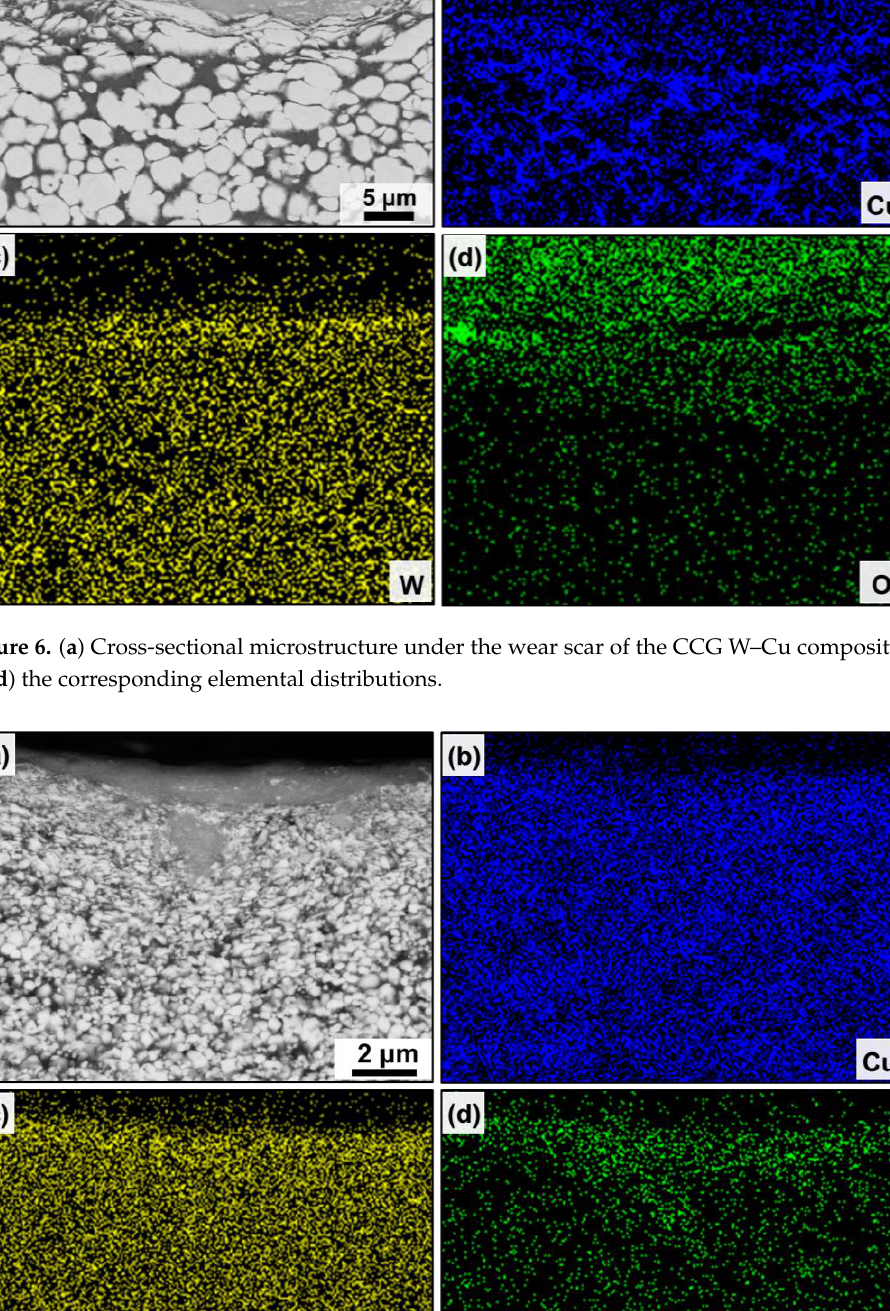
Figure 7. ( a ) Cross-sectional microstructure under the wear scar of the UFG W – Cu composite and ( b – d ) the corresponding elemental distributions.